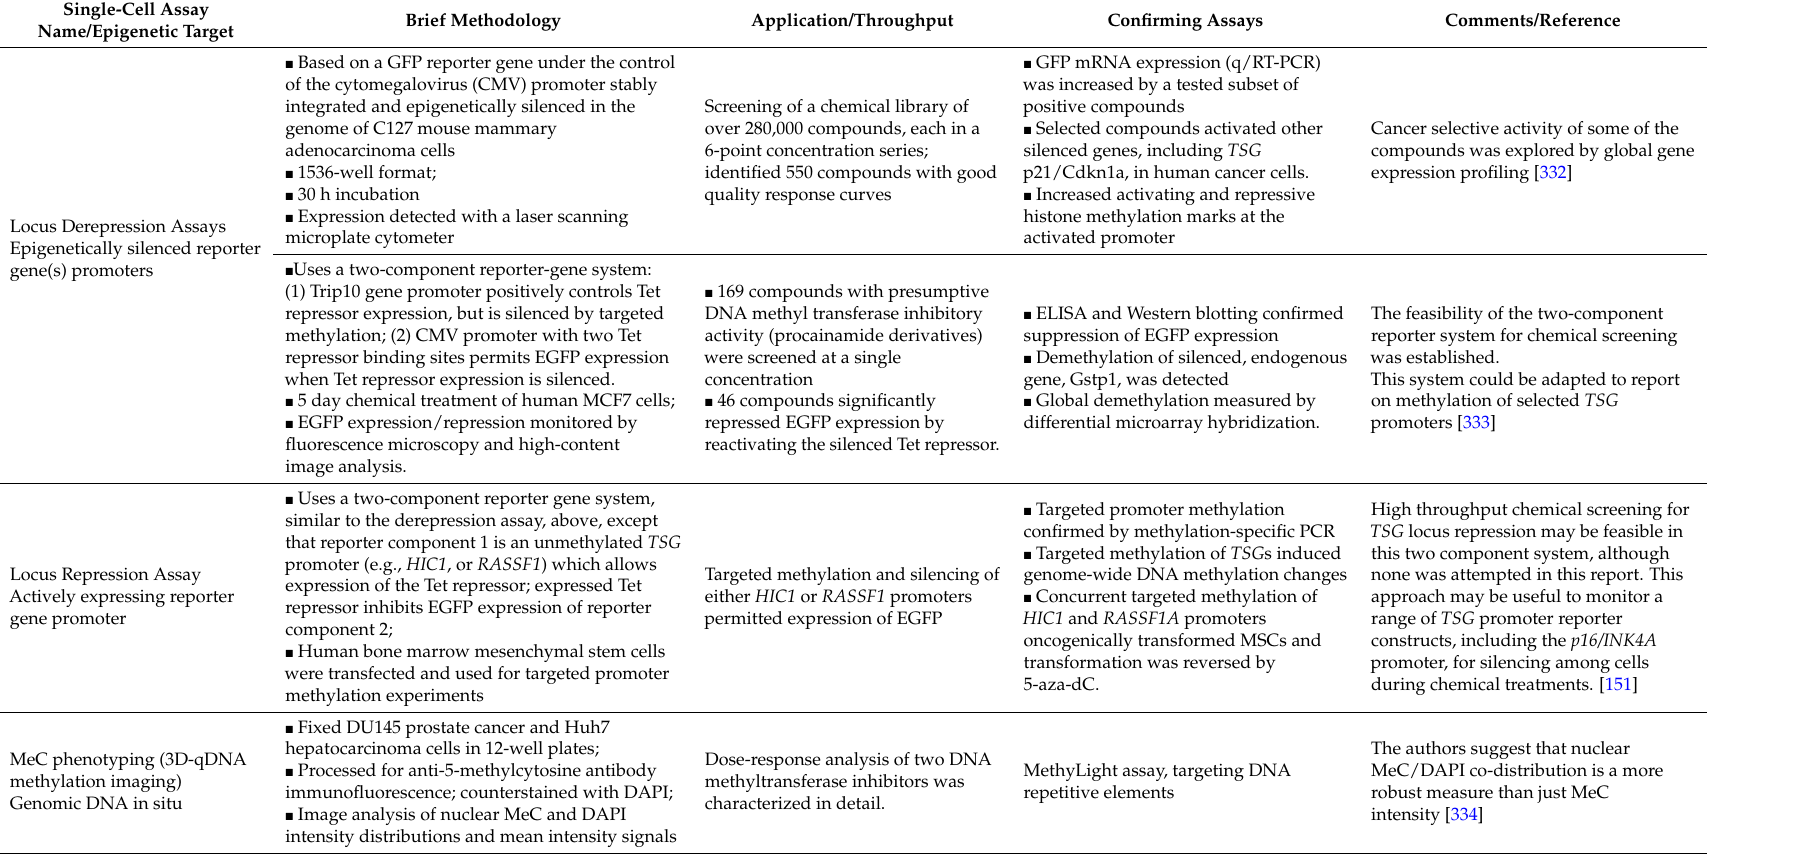
Table 7. In vitro cell screening assays with cell-by-cell readouts for effects on epigenetic pathway components. Single-Cell Assay Name/Epigenetic